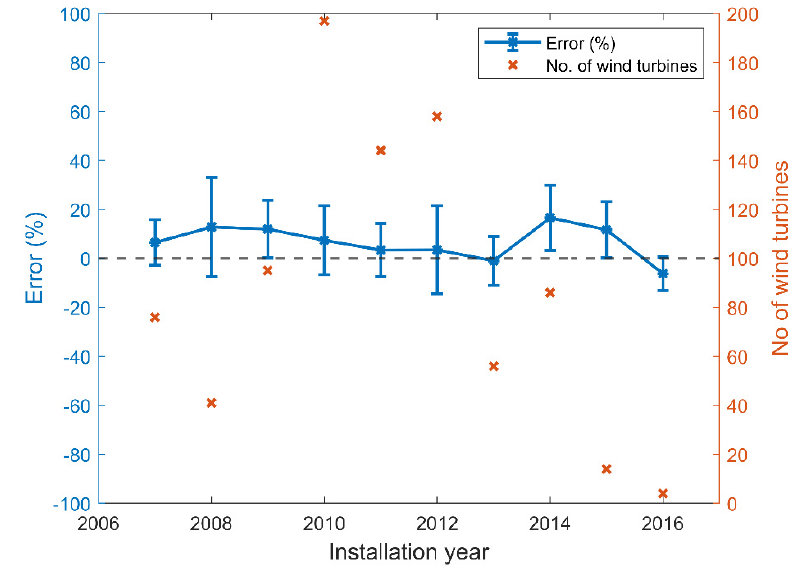
Figure 4. Error of P50 evaluations compared to the production-based WCP depending on the installation year plotted with the standard deviation (blue) and number of wind turbines (red).